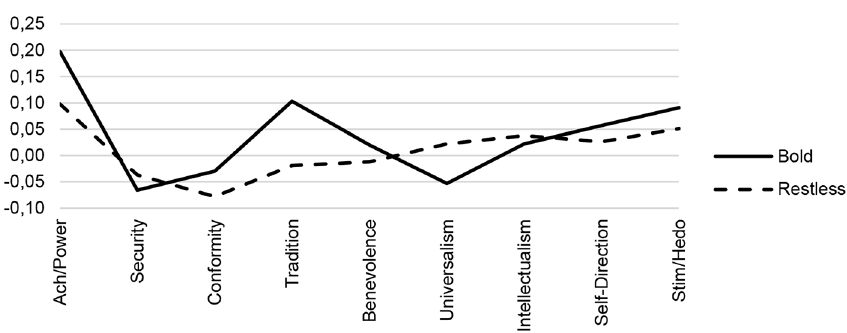
Figure 4. Results for negative emotional tendency traits (bold and